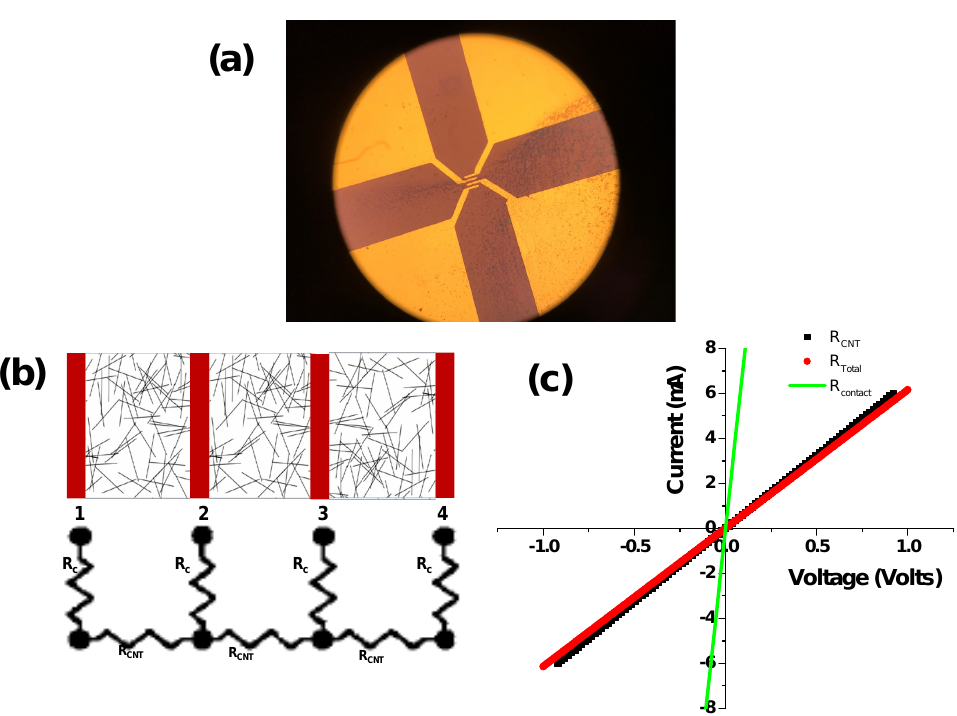
Figure 4. ( a ) Optical image of the four metal contacts deposited on top of the MWCNT network, ( b ) Schematic showing the series combination of CNTs and contacts represented as resistors, ( c ) Current- voltage characteristics for the MWCNTs, and the series combination of the metal contacts and CNTs. The difference between the total resistance and the CNT resistance provides the contact